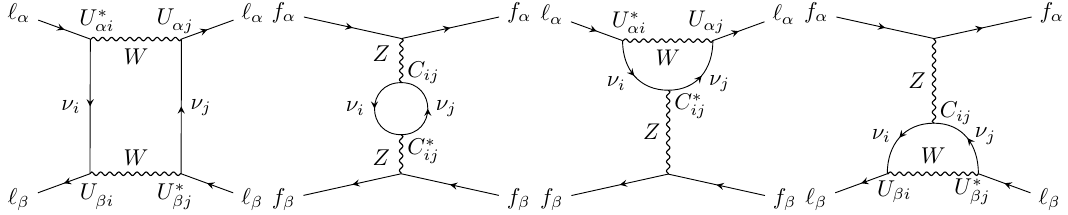
Figure 2 . Diagrams depicting the exchange of two massive neutrinos between fermions f (cid:11) and f (cid:12) with SM CC and NC interactions at each vertex. For the CC interactions f = ‘